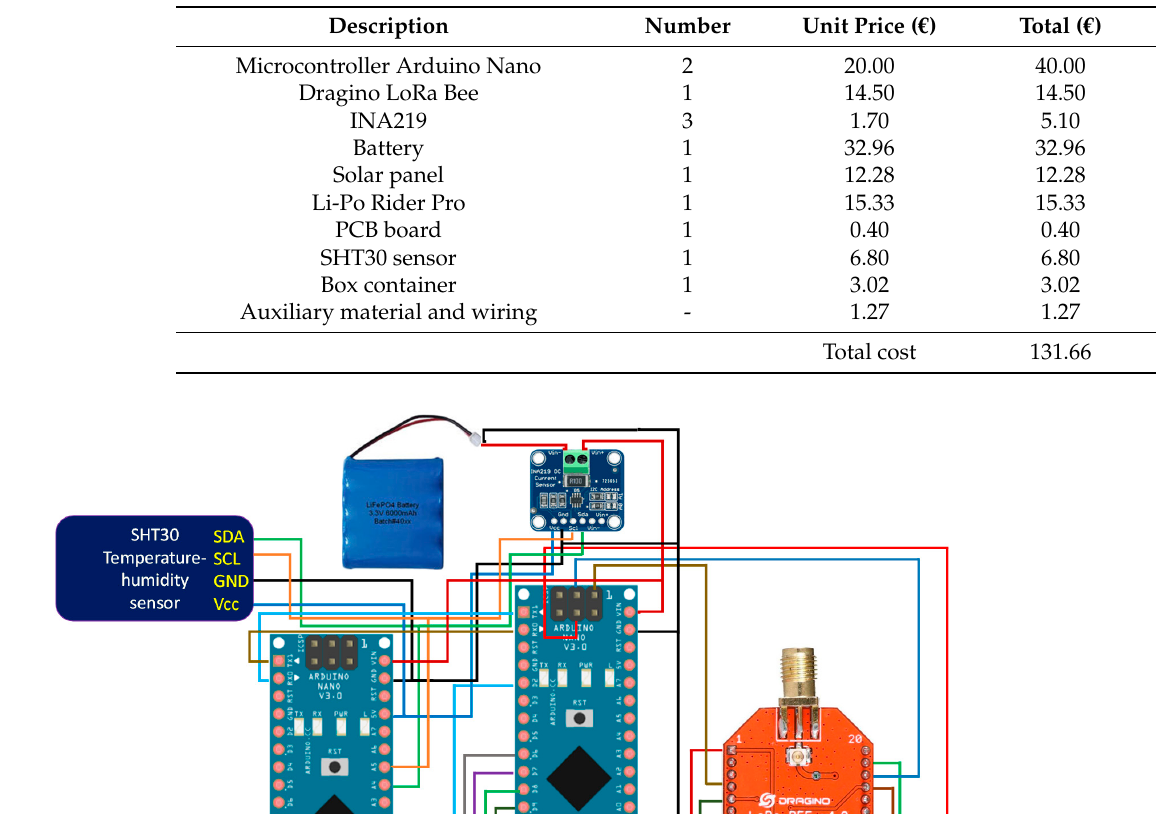
Table 8. Cost of components for the THMDL with a battery and solar panel power supply.